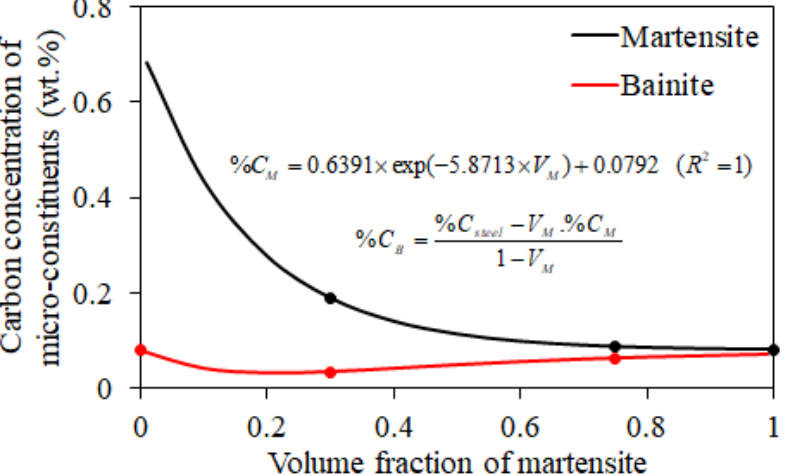
Figure 16. The calculated carbon concentrations in martensite and bainite within Ductibor ® 1000-AS bainitic-martensitic microstructures with various phase amounts (%v). The solid lines represent the model predictions, and the markers denote the values for the reference microstructures.